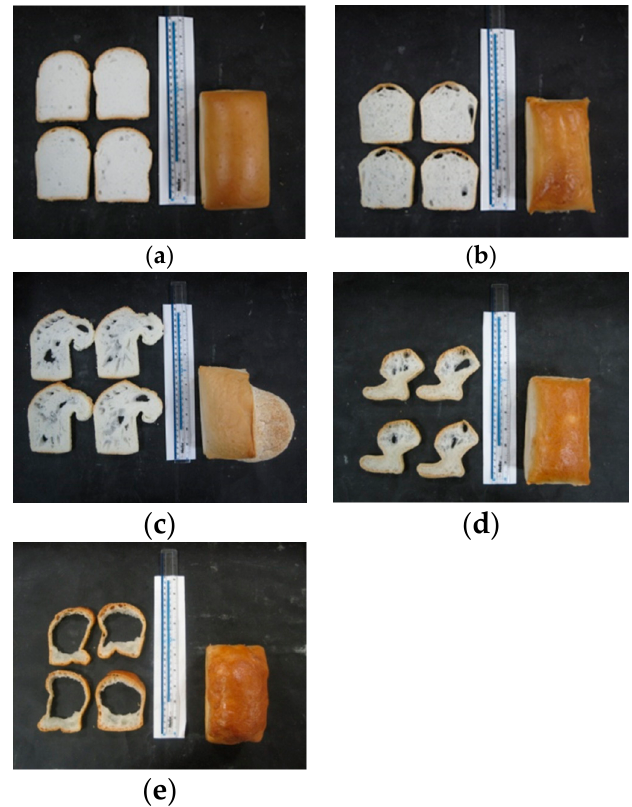
Figure 4. Images of the breads obtained with different starches: ( a ) wheat starch, ( b ) potato starch, ( c ) corn starch, ( d ) tapioca starch, and ( e ) rice starch.